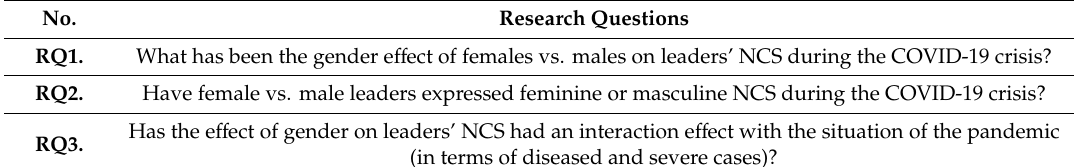
Table 1. Research